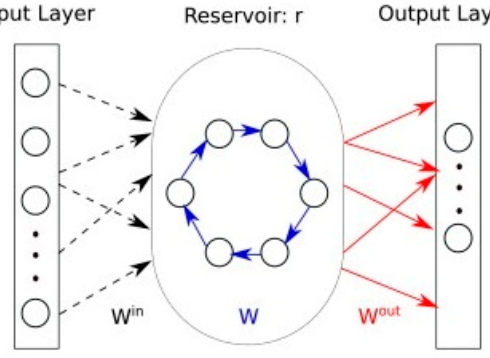
Figure 6. Representation of standard ESN (Echo State Networks) architecture.